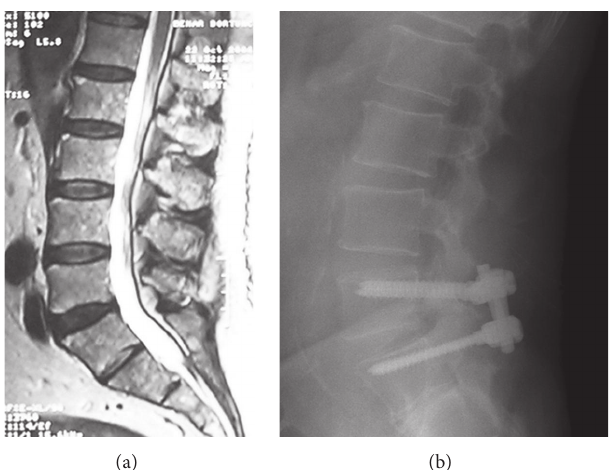
F 2: (a) A 50-year-old male complained of severe back pain attacks. (a) T2-weighted MRI scans showed degeneration of the disc at L4-L5 lumbar disc (L5- S1 considered as sacralization). (b) Following posterior transpedicular dynamic stabilization with the Cosmic system.